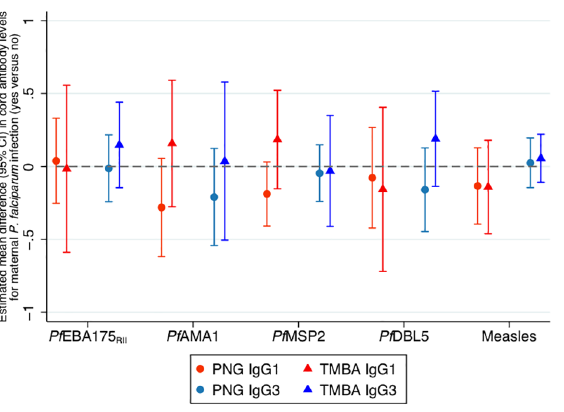
Fig 3. Association of maternal P . falciparum infection with maternofetal antibody transfer. Estimates and 95% confidenceintervals are presented of the mean difference in log 2 cord antibody levels after adjustmentfor log 2 maternal antibody levels and gravidity, for mothers with a P . falciparum infectionduring pregnancy comparedto uninfectedmothers. Dashedline at 0 indicatesno difference in mean log 2 cord antibody levels. See S2 Table for a table versionof this